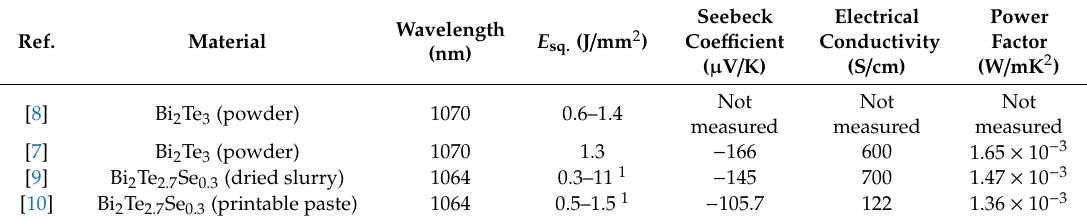
Table 1. Overview over previous studies on laser treatment of bismuth telluride materials.